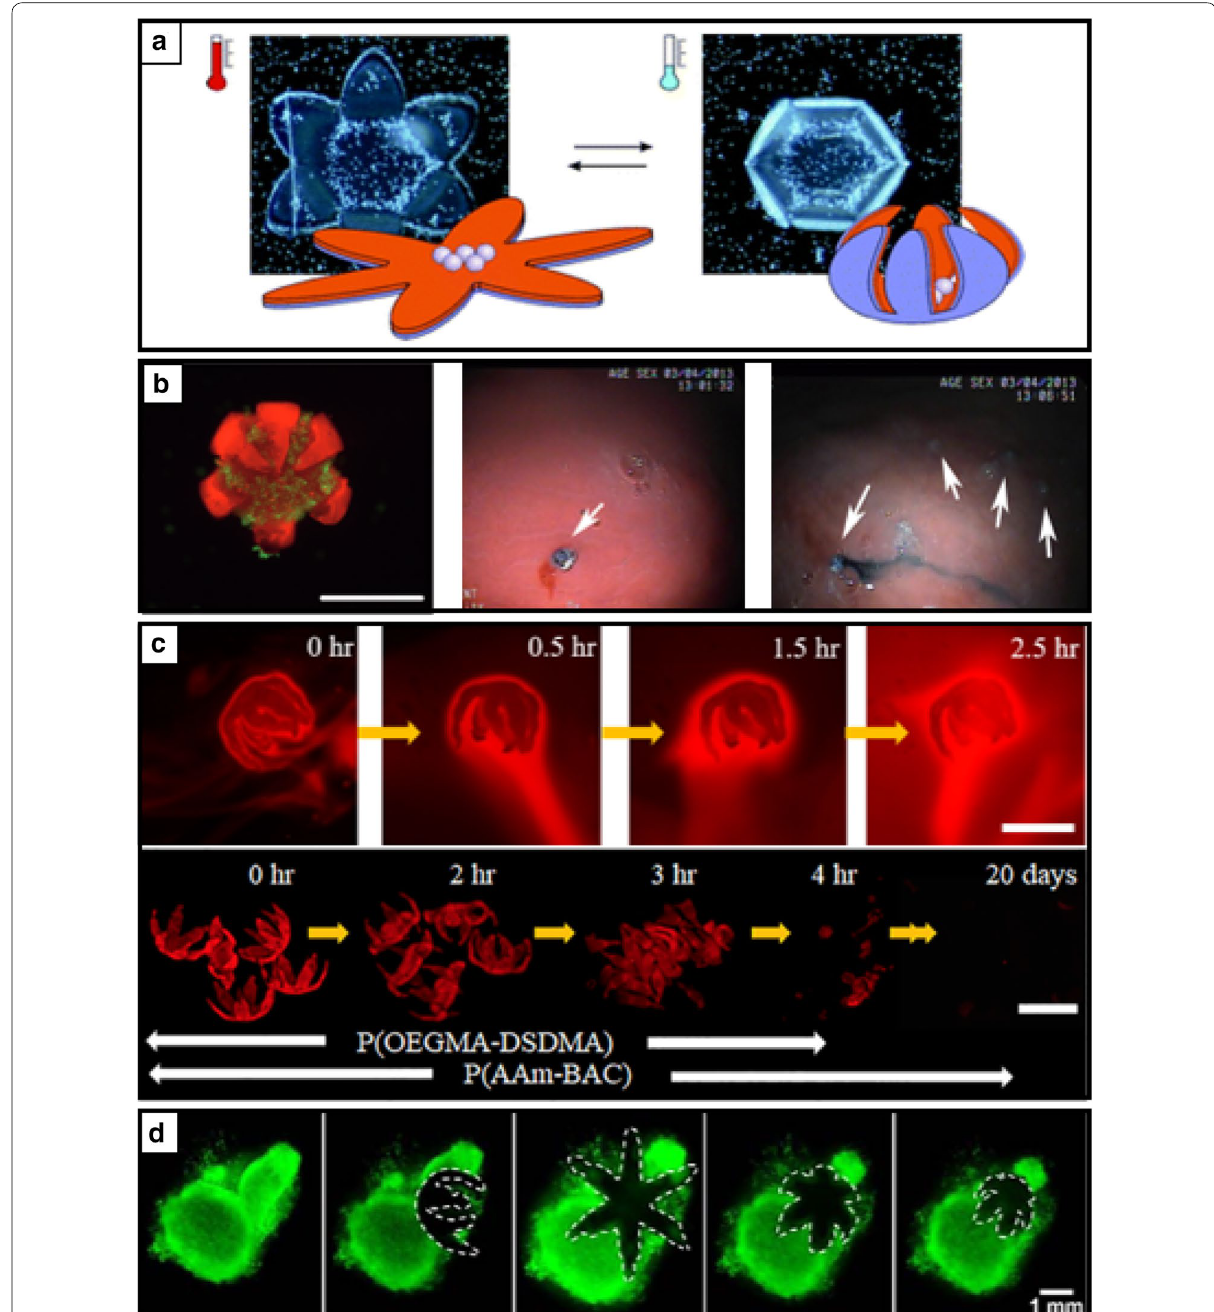
Fig. 7 Stimuli responsive soft grippers for biomedical drug delivery or surgical biopsy. a Thermoresponsive self-folding microgrippers that can capture yeast cells by the deswelling induced contraction in the thermoresponsive layer that results in bending of the soft gripper at low temperature (reproduced with permission [18]. Copyright 2011, The Royal Society of Chemistry). b Therapeutic soft gripper that can grasp a clump of cells and demonstrate the endoscopic in vivo food dye delivery test to porcine stomach (reproduced with permission [10]. Copyright 2014, Wiley–VCH). c Biodegradable thermomagnetically responsive soft gripper for drug delivery (reproduced with permission [83]. Copyright 2018, American Chemical Society). d Self-folding thermo-magnetically responsive soft gripper that can capture and excision of cells from a live fibroblast clump (reproduced with permission [9]. Copyright 2015, American Chemical